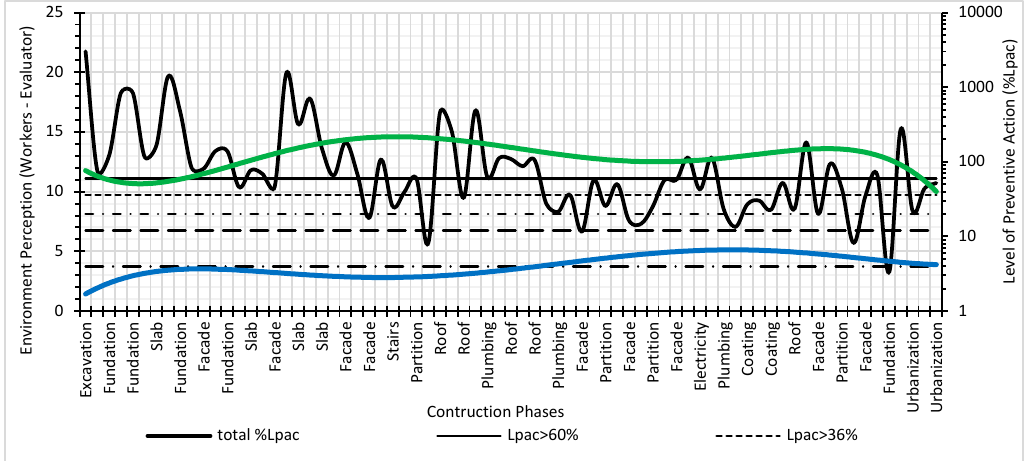
Figure 13. Level of preventive action and perception of the risk of the workers and the evaluator.